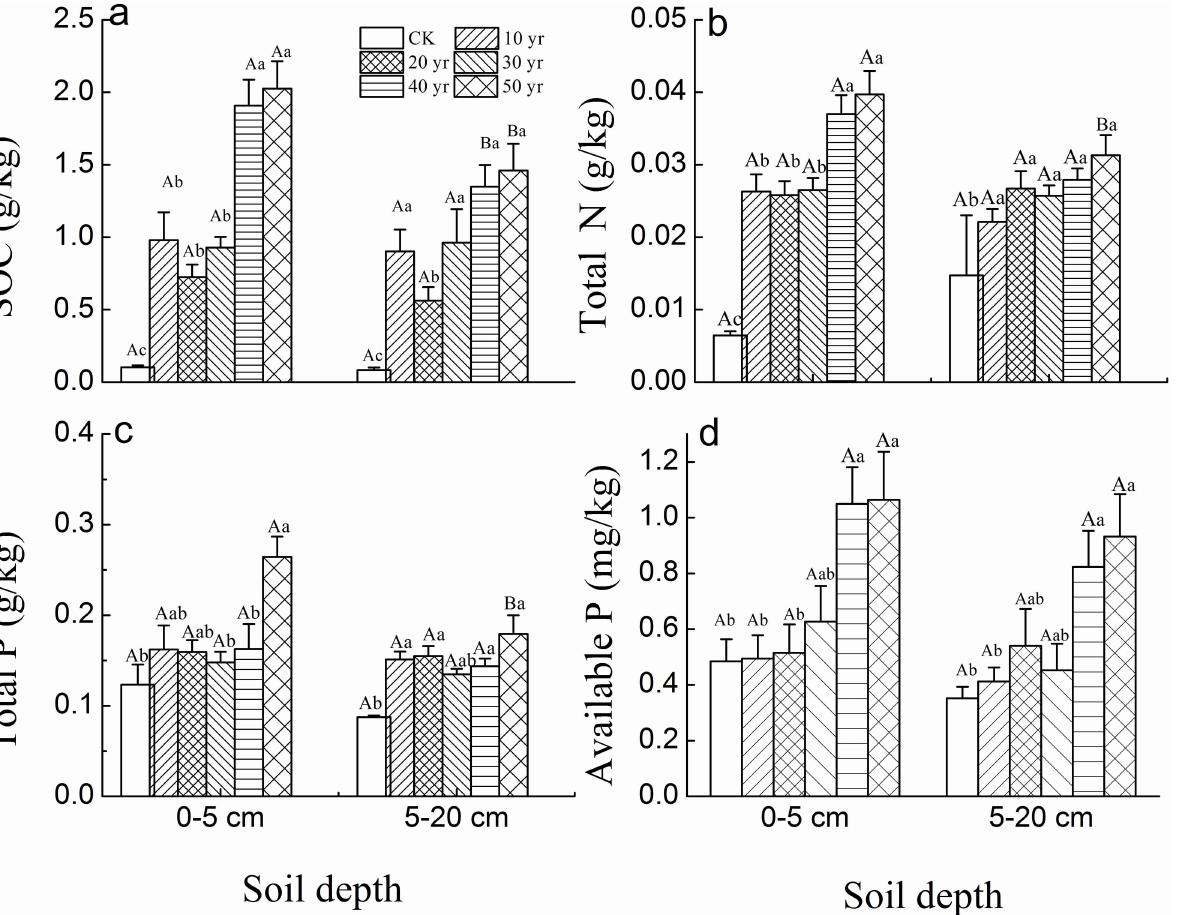
Fig 4. Mean concentration of the SOC, total N and total and available P (mean ± SE) for H . ammodendron plantations planted in different decades across 50 years (CK-mobile sand dune). (Different uppercase letters indicatesignificantdifferences in soil properties between two soil depths in the same plantation age at p < 0.05.Different lowercaseletters indicatesignificantdifferences in soil properties among different plantation ages with the same soil depth at p <